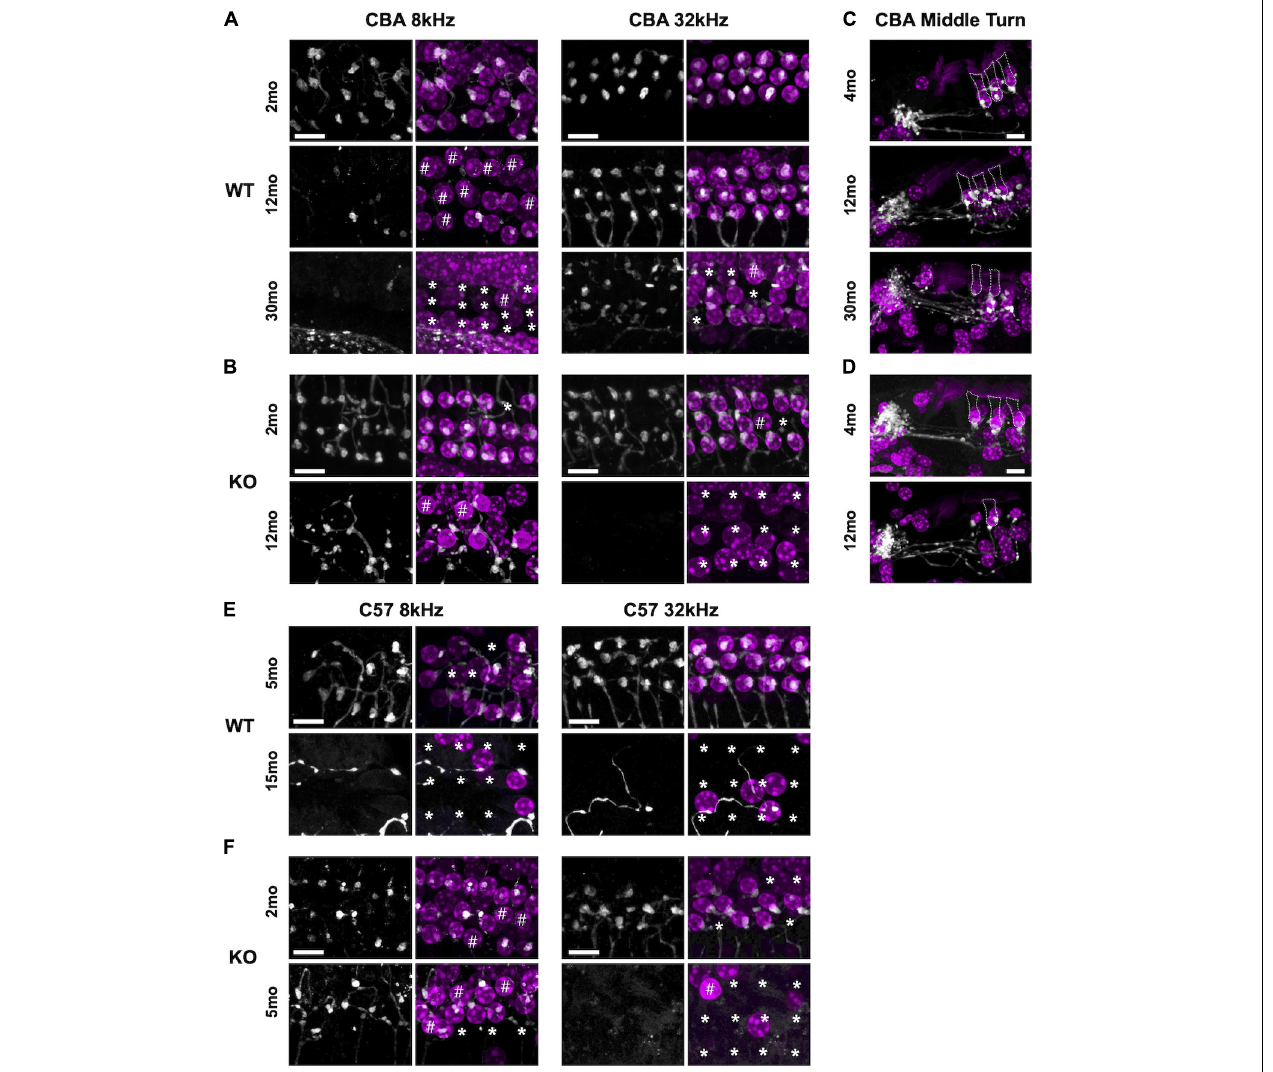
FIGURE 5 | Efferent clusters are lost at the extreme ends in aging WT and KO mice. Surface preparations showing choline acetyltransferase (ChAT)-labeled efferent clusters in the 8 and 32 kHz regions of panel (A) CBA WT and (B) CBA KO mice. * Missing OHCs, # OHCs without ChAT clusters. (C,D) Mid-modiolar sections of ChAT-labeled clusters in the middle turn of panel (E) CBA WT and (F) CBA KO mice. Dotted lines represent OHC borders from adjacent OHC in each row. Scale bars represent 10 µ